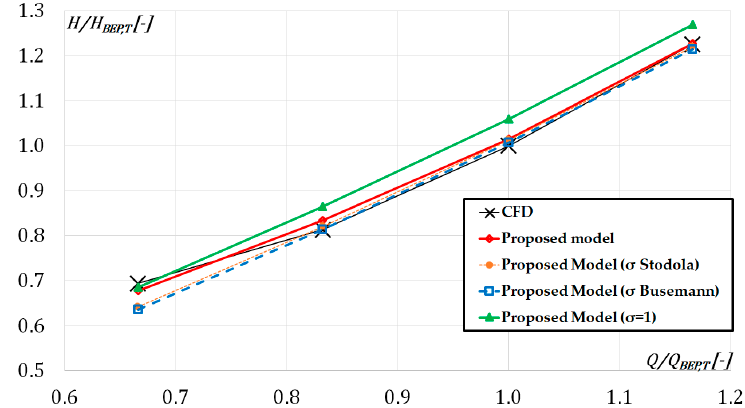
Figure 26. Comparison of different sources of losses for the performance prediction.